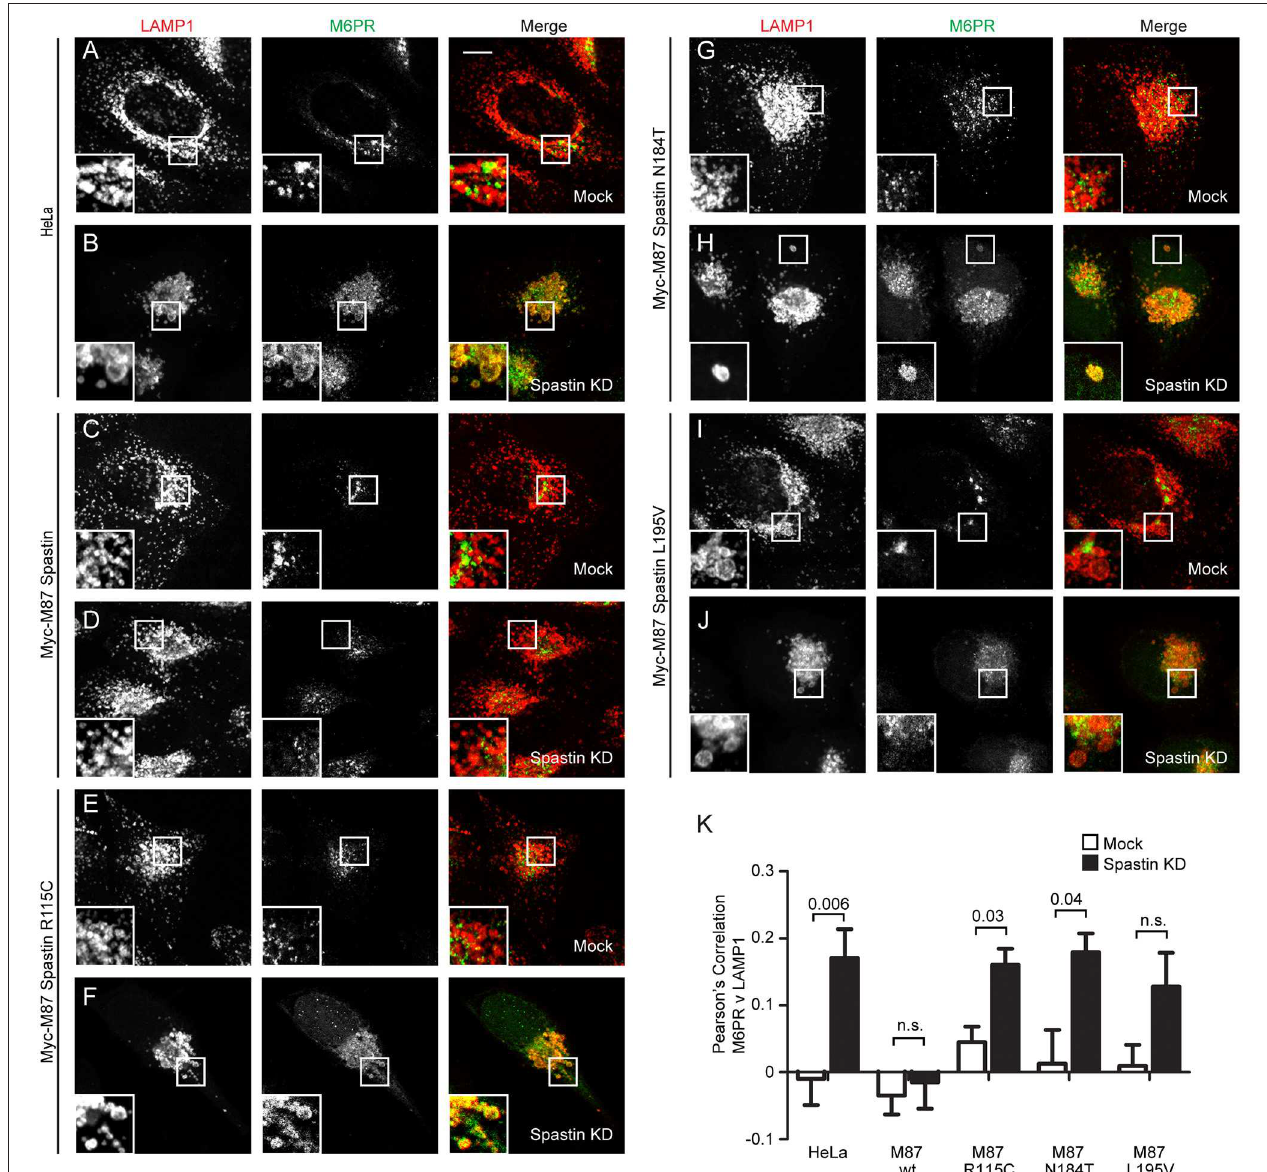
FIGURE 2 | Endosome to Golgi M6PR traffic is disrupted by MIT domain mutations in spastin. (A–J) Wild-type HeLa cells or cells expressing the siRNA-resistant spastin constructs indicated were subjected to mock transfection or siRNA-mediated KD of endogenous spastin, then processed for immunofluorescence microscopy and labeled with antibodies to M6PR and the lysosomal marker LAMP1. Insets show higher magnification views of the boxed areas. Scale bar = 10 µ m. (K) Co-localization between M6PR and LAMP1 was quantified by calculating the Pearson’s correlation coefficient for red and green pixels in each cell using Volocity software (20 cells per condition quantified in each experiment). Mean and SEM are shown for n = 4 experiments. P -values were calculated using paired two-tailed t